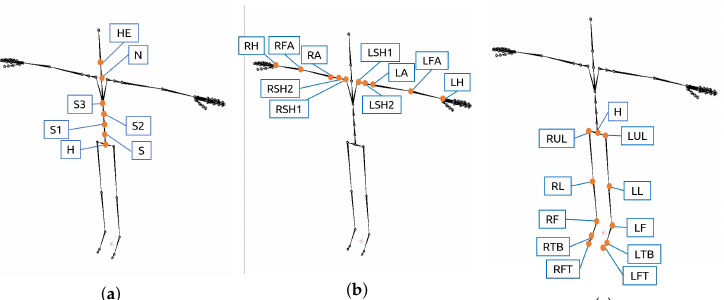
Figure 7. Location of the sensors that provide the XYZ joint angles included in GOM’s state-space equations. ( a ) Spine parts; ( b ) Arm parts; ( c ) Leg